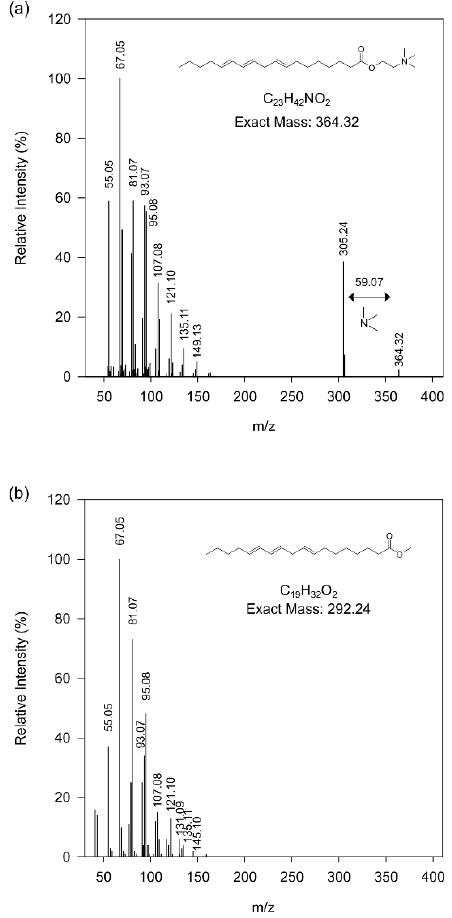
Figure 5. Identification of fatty-choline differentially accumulated on kale populations with high and low glucosinolates content ( a ) MS/MS spectrum of the putative linoleyl-choline. ( b ) MS/MS spectrum of linoleic acid methyl ester obtained from METLIN.